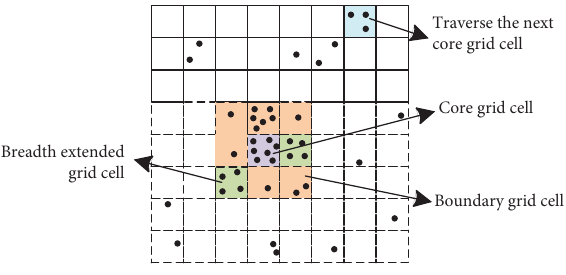
Figure 4: Irregular dynamic region division